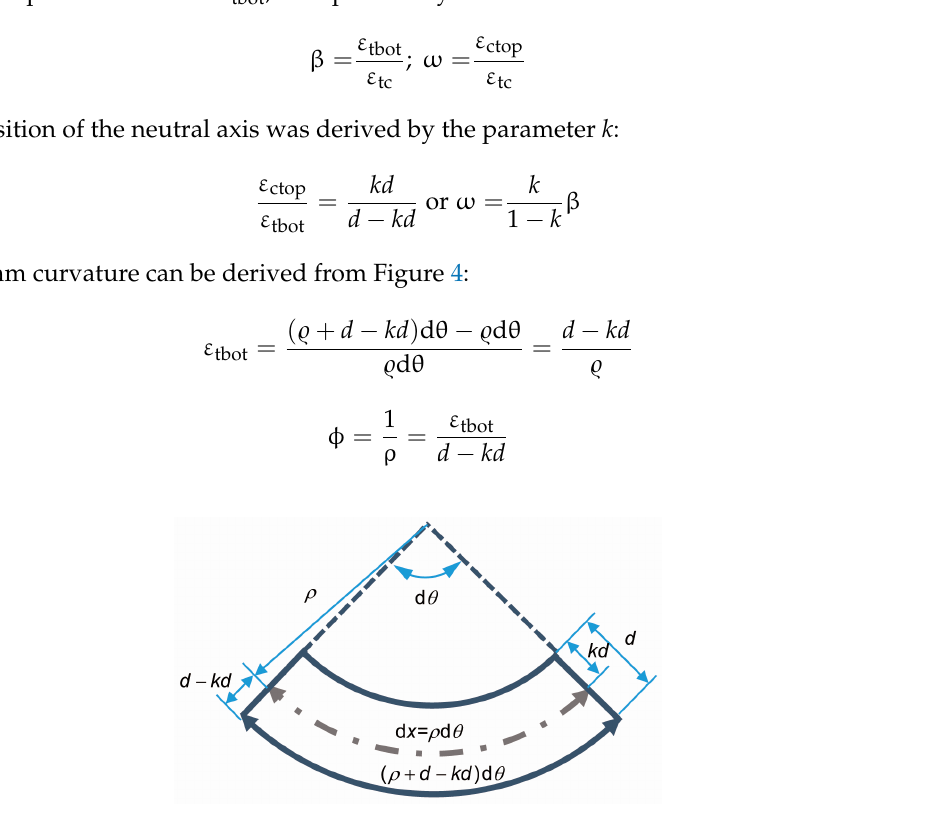
Figure 4. The curvature of a differential beam element.